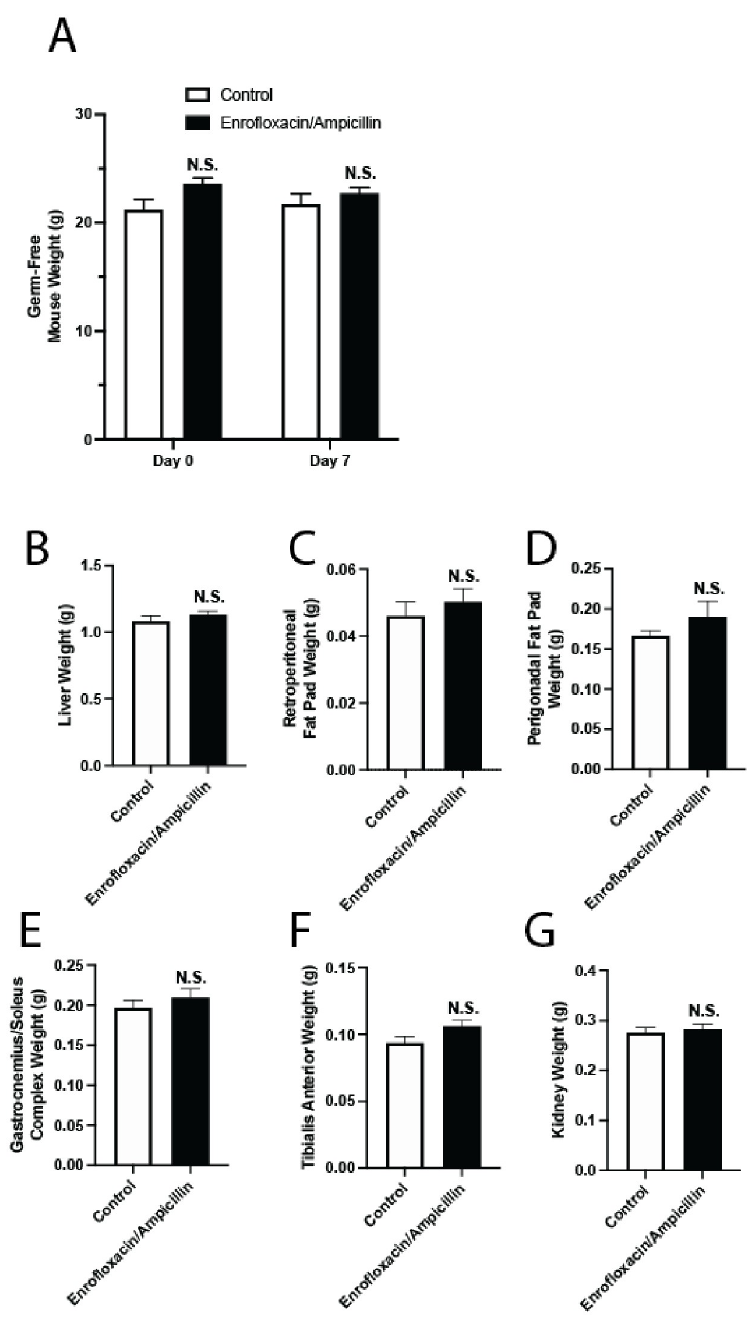
Fig 7. Oral antibiotic administration does not reduce organ/tissue weight in germ-free mice. Germ-free C57BL/6 mice were provided distilled drinking water, with or without 0.27 g/L enrofloxacin and 1 g/L ampicillin, for 8 days. (A) Comparison of mouse body weights at 0 and 7 days. Error bars denote SEM. n = 7, N.S. denotes non-significance, P > 0.05. (B-G) Mice were necropsied on day 8, and liver (B), retroperitoneal fat pads (C), perigonadal fat pads (D), bilateral gastrocnemius-soleus complex muscles (E), bilateral tibialis anterior muscles (F), and kidneys (G) were compared. Error bars denote SEM. n = 7, N.S. denotes non-significance, P >